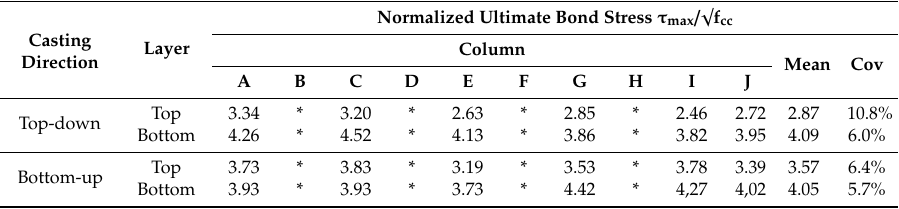
Table 5. Normalized ultimate bond stress for the rebars in all elements.